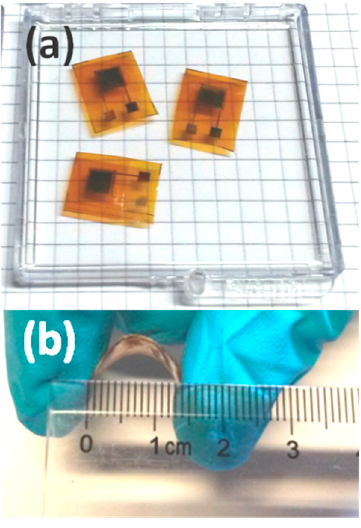
Figure 7. Image representative of the different PPT prototypes ( a ) as prepared and ( b ) under bending conditions.